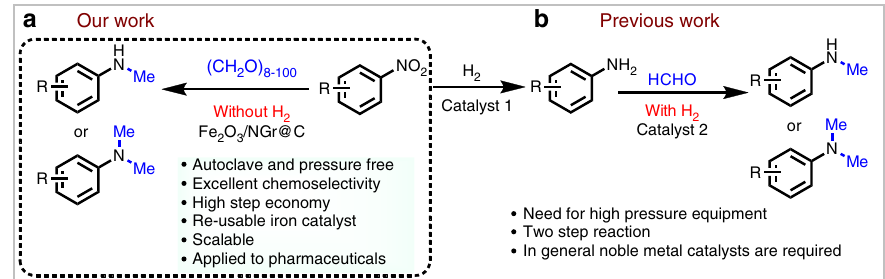
Fig. 2 Reductive methylation of nitroarenes to N -methylamines. a Present work representing the straight forward synthesis of N -methylamines from nitroarenes without external hydrogen. b Previous works showing two-step process for the preparation of N -methylamines in presence of external